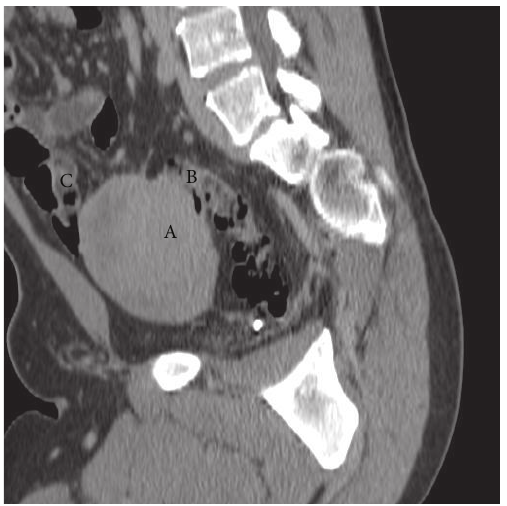
Figure 1: Abdominal computed tomography (sagittal reconstruc- tion): A: desmoid-type fibromatosis; B: sigmoid colon involved; C: ileal loop involved.